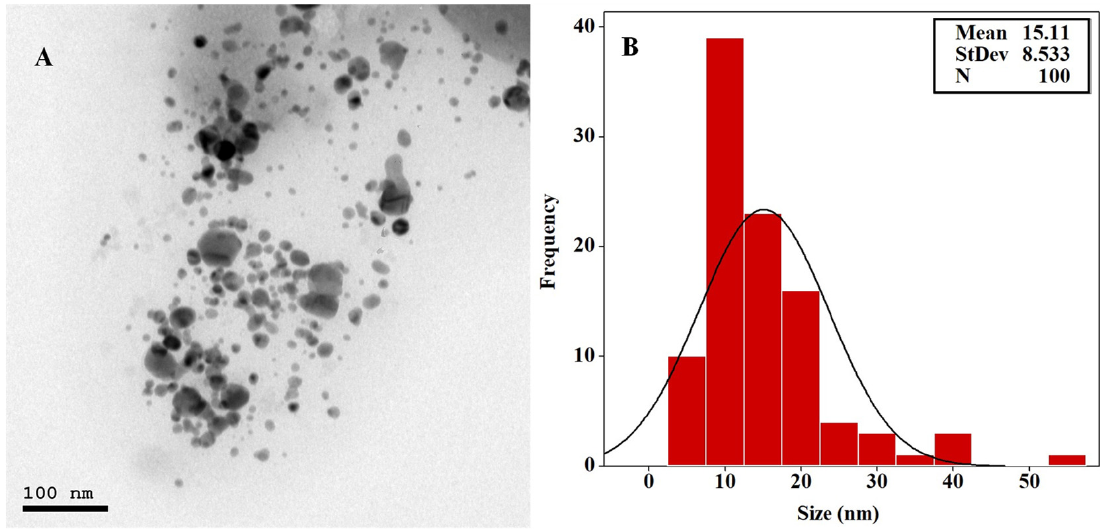
Figure 2. Transmission electron microscopy of AuNPs synthesized by aqueous extract of Z. officinale rhizome. ( A ) TEM image (spherical and well-dispersed NPs); ( B ): size distribution (determination based on TEM image analysis).